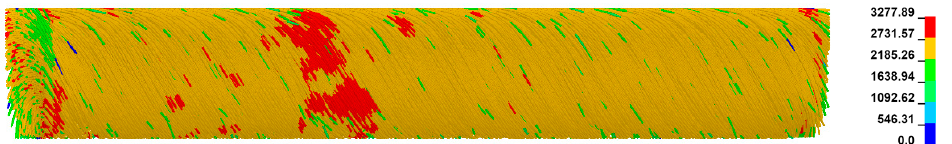
Figure 13. Axial fiber stresses during composite simulation of a yarn with 30 T/m (matrix elements hidden for clearity).